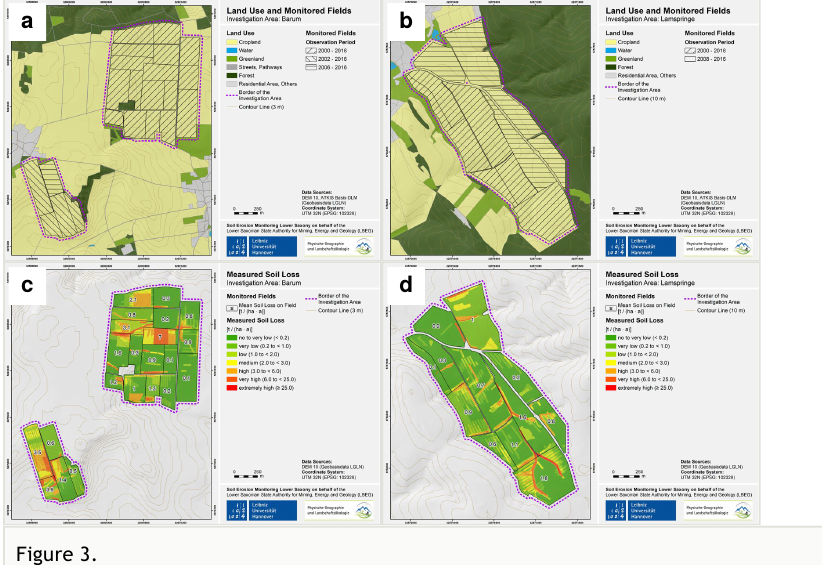
Maps of the land use and monitored fi elds and the mean annual measured soil loss for the years 2000 to 2016 for two exemplary investigation areas. a : Land use and monitored fi elds for the investigation area Barum (northern region). b : Land use and monitored fi elds for the investigation area Lamspringe (southern region). c : Measured soil loss in the investigation area Barum (northern region). d : Measured soil loss in the investigation area Lamspringe (southern